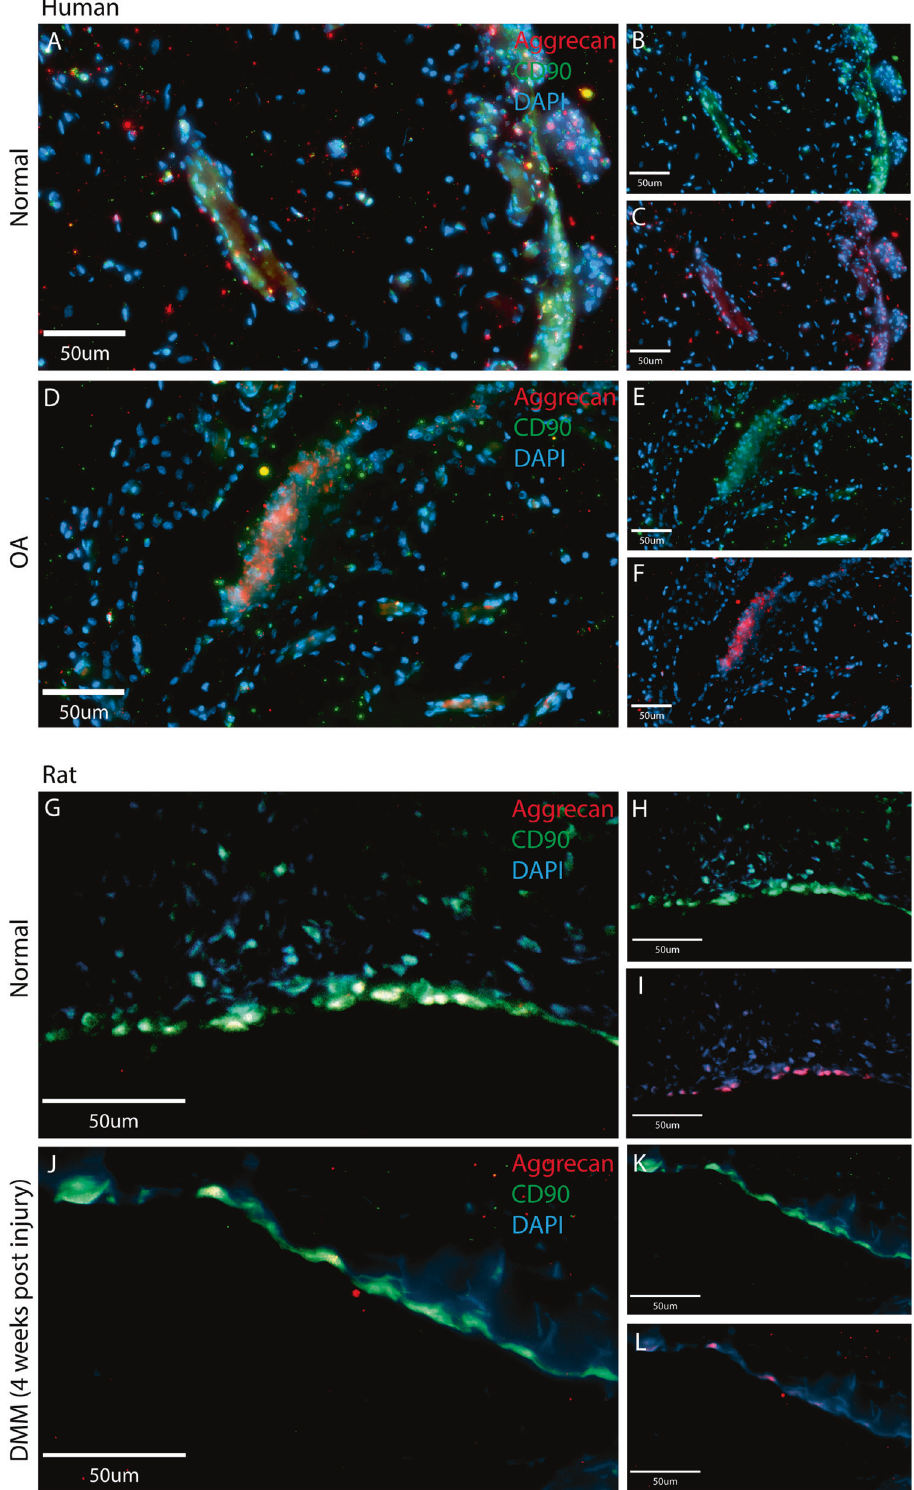
Fig. 6 Aggrecan staining co-localizes with CD90 expressing in human and rat synovium. Human (normal and OA) and rat (normal and OA) synovium was doubled labeled for aggrecan (red) and CD90 (green), a marker of synovial progenitor/MSCs in both human and rat. In normal human synovium ( A ), CD90 ( B ) and aggrecan ( C ) were found to be highly co-localized, mainly at the intimal surface, but also within the sub- intimal layer adjacent to vessels. In OA synovium ( D ), CD90 ( E ) and aggrecan ( F ) were also found to be highly co-localized in the intimal and sub-intimal layers. In normal rat synovium ( G ), CD90 ( H ) positive cells were also found to express aggrecan ( I ). In OA synovium ( J ), CD90 ( K ) positive cells also expressed aggrecan ( L ). Scale bars equal 50 µm.